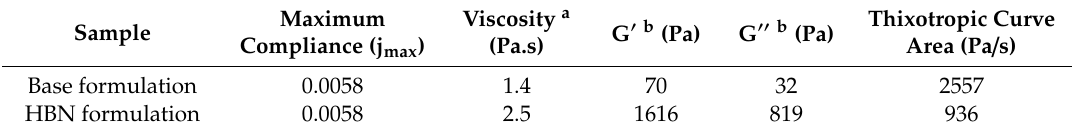
Figure 2. ( A ) Mechanical spectra of the control system (base) and the formulation at 25 °C. ( B ) Shear rate-dependent viscosity changes in the control and the formulation at 25 °C. Error bars were always lower than 10%. The error bars are omitted for clarity purposes. Table 1. Rheological properties of the control and the experimental formulation.